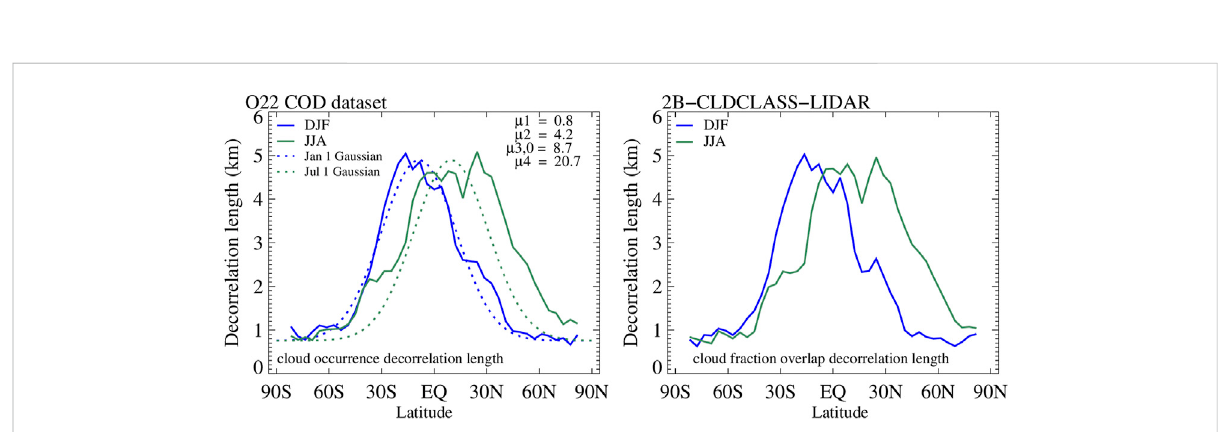
FIGURE 3 (Left panel) : Zonal variation of the cloud occurrence decorrelation length parameter L α , modulating the exponential decay of α vs. separation distance according to Eq. 2, for DJF and JJA from the O22 COD dataset; we also show Gaussian fi ts (dotted curves) corresponding to Eq. 7 with µ parametersprovidedonthetoprightcornerforJanuary1standJuly1st. (Rightpanel) :astheleftpanel,butfromthecloudmaskprovidedbythe2B- CLDCLASS-LIDAR